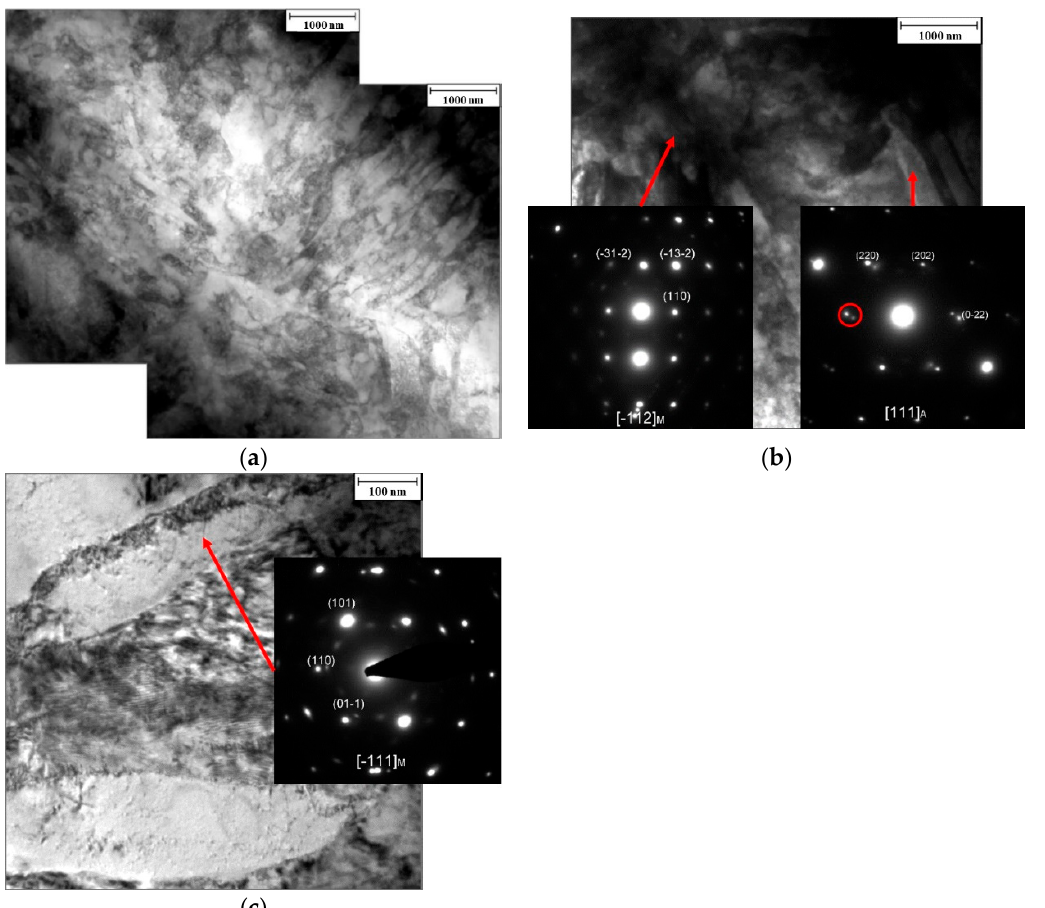
Figure 5. D 0 specimen transmission electron microscope (TEM) micrographs taken on the T section showing ( a ) the presence of austenite at the boundary of the melting pool and martensite inside the melting pool; ( b ) martensite laths (M) and twinned austenite grains (A) with a selected-area electron diffraction patterns (SAEDP) inset showing a red circle for the twinning diffraction spots; ( c ) martensite laths.